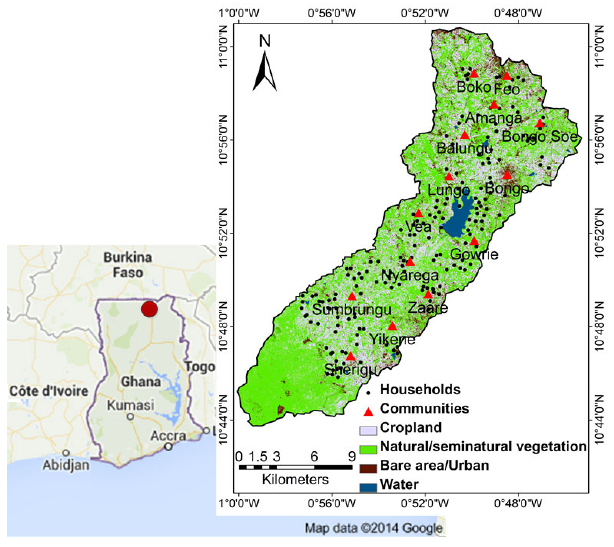
Fig. 1 . Study area map of Vea catchment in the districts of Bongo and Bolgatanga, Upper East Region of Ghana, West Africa. The red dots are the locations of the households that participated in the